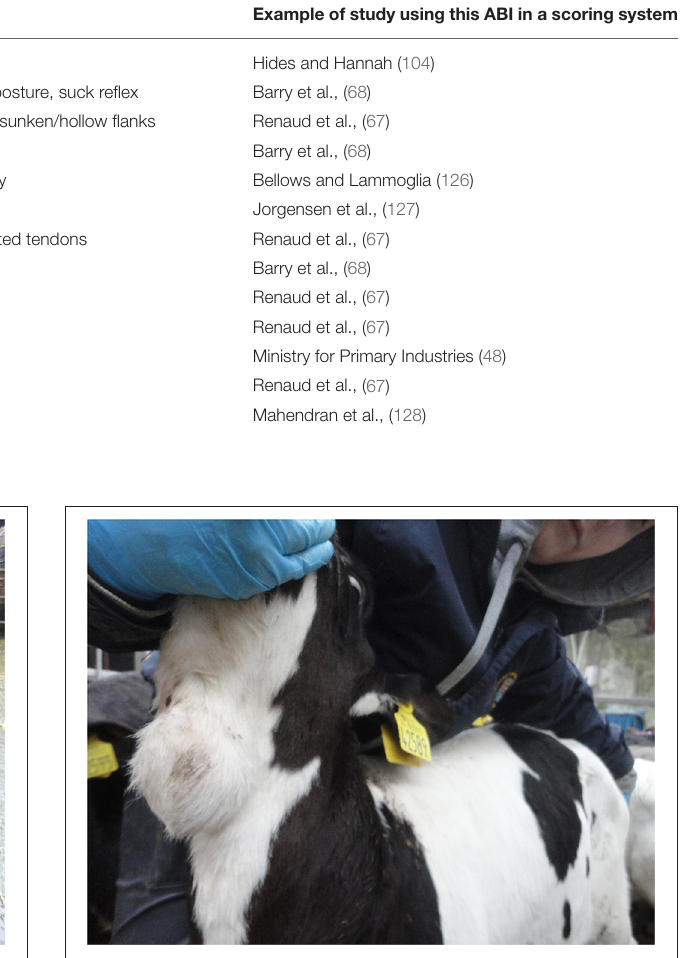
FIGURE 1 | Injection site swelling under the skin on the shoulder. FIGURE 2 | Abscess under the skin in the neck of a young